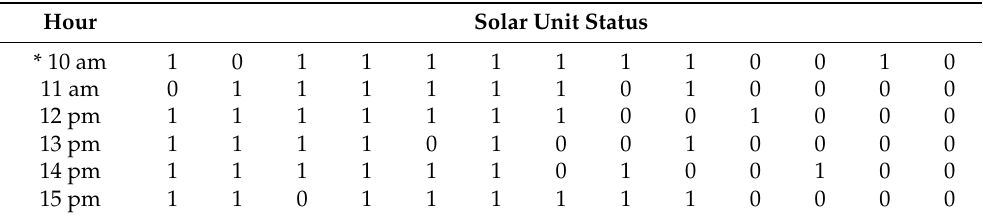
Table 14. Solar unit switching status for the analysis.